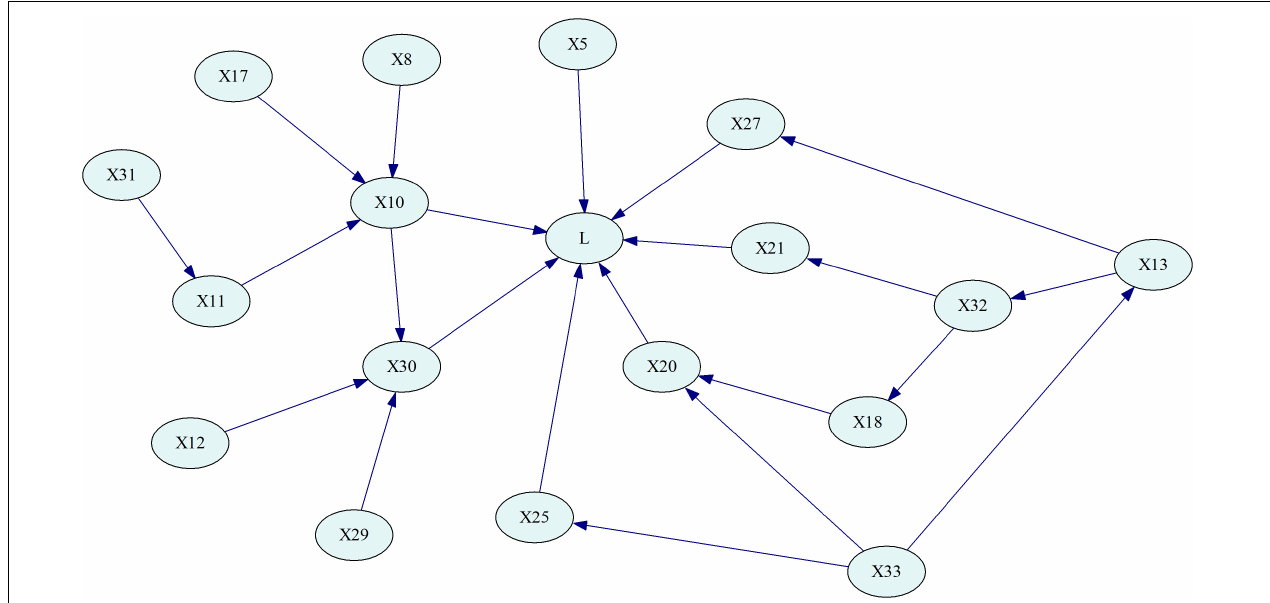
FIGURE 5 | Bayesian network structure learning